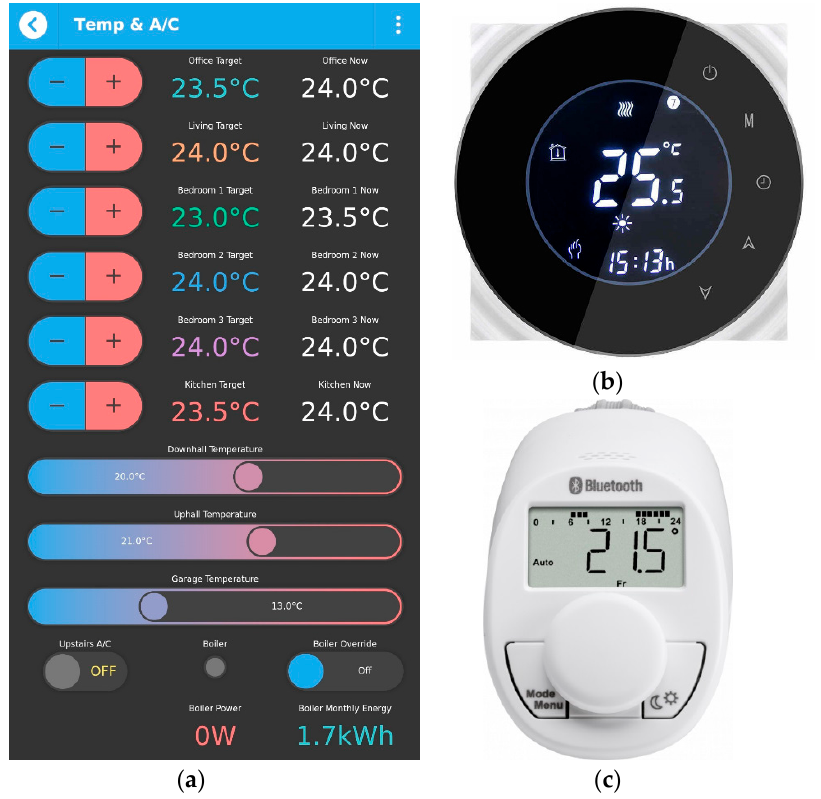
Figure 8. Controlling indoor temperatures with qToggle app ( a ) together with smart termostats ( b ) and ( c